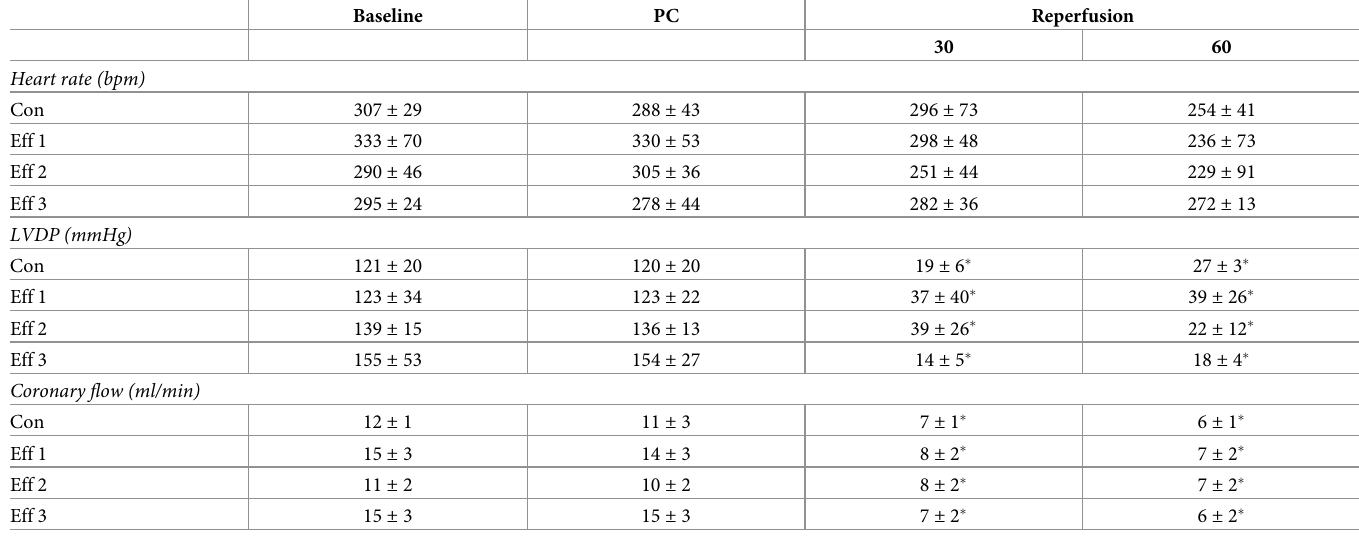
Data are mean ± SD. Con = Control; Eff 1 = effluent after one cycle of IPC; Eff 2 = Effluent after two cycles of IPC; Eff 3 = Effluent after three cycles of IPC. � P < 0.05 vs.